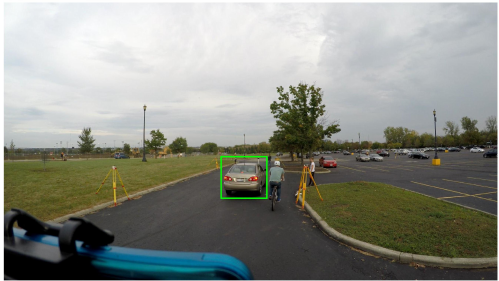
Figure 8. Example of car detection with Yolo v3 Network.